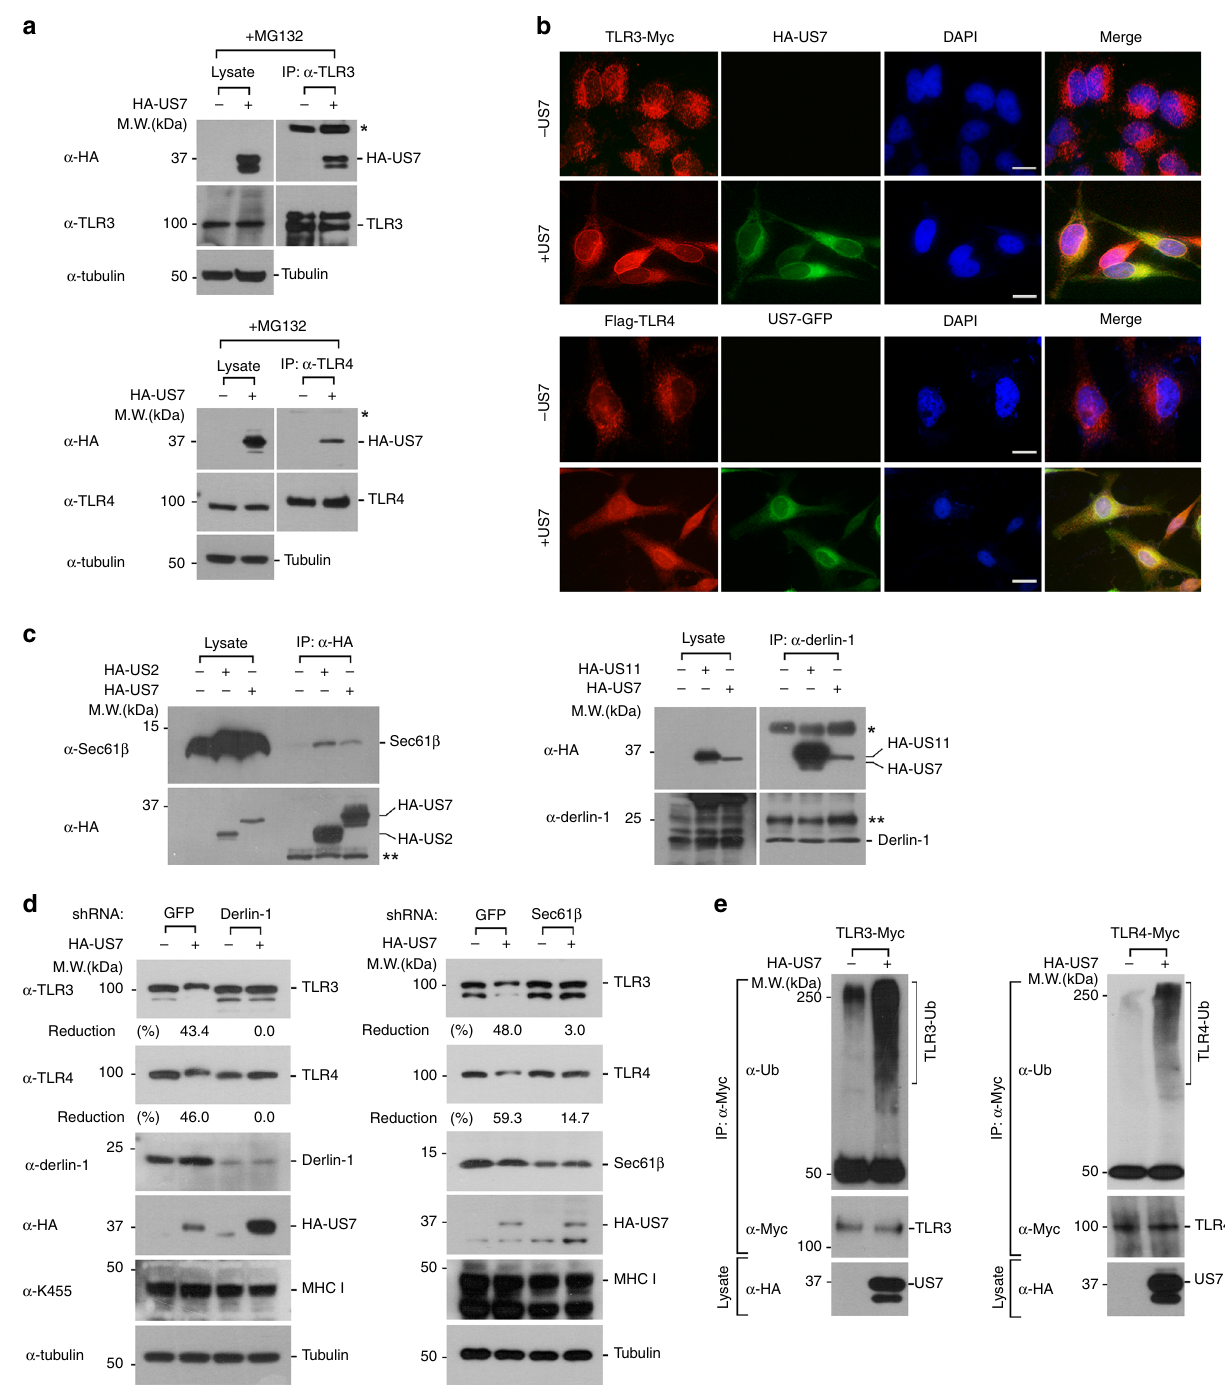
Fig. 3 US7-mediated TLR3 or TLR4 degradation requires Derlin-1/Sec61 and ubiquitination. a US7 physically interacts with TLR3 and TLR4. HeLa cells were transfected with empty vector or HA-US7 and treated with 20 μ M MG132 for 4 h. Lysates were immunoprecipitated with anti-TLR3 or anti-TLR4 antibody and then immunoblotted with anti-HA, anti-TLR3, anti-TLR4, or anti-Tubulin antibody. Asterisk denotes immunoglobulin (Ig) heavy chains. b US7 co- localizes with TLR3 or TLR4. HeLa cells expressing TLR3-Myc or Flag-TLR4/MD2-Myc were transfected with empty vector, US7-GFP or HA-US7 and then stained with anti-Myc, anti-Flag or anti-HA antibody. DAPI was used as a nuclear counterstain. Data are given as the average fl uorescence intensity (FI) per cell in the selected fi elds. Scale bars, 10 μ m. c US7 binds to both Sec61 β and Derlin-1. Lysates from HA-US7-expressing HEK 293 T cells were immunoprecipitated with anti-HA and anti-Derlin-1 and immunoblotted with anti-Sec61 β , anti-Derlin-1, or anti-HA antibody. HA-US2 or HA-US11 served as a control. *, Ig heavy chains; **, Ig light chains. d US7-mediated TLR3 and TLR4 degradation depends on Sec61 β and Derlin-1 expression. HeLa cells stably expressing control shRNA, Sec61 β , or Derlin-1 were transfected with HA-US7. Lysates were immunoblotted with the indicated antibodies. e US7 promotes TLR3 and TLR4 ubiquitination. Cells expressing TLR3-Myc or TLR4-Myc with or without HA-US7 were treated with 20 μ M MG132 for 4 h and lysed. Cell extracts were immunoprecipitated with anti-Myc antibodies and then analyzed by immunoblotting with anti-Ubiquitin, anti-HA, anti-Tubulin and anti-Myc antibodies. Data are representative of at least three independent experiments. Source data are provided as a Source Data fi